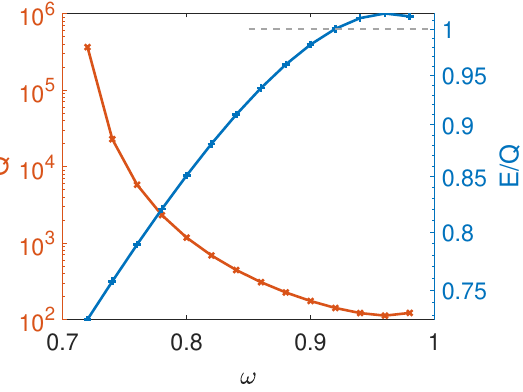
Figure 28. Dependence of total charge Q and energy-charge ratio E/Q on frequency ω of an elementary Q-ball in 3+1D in the potential (2.3).